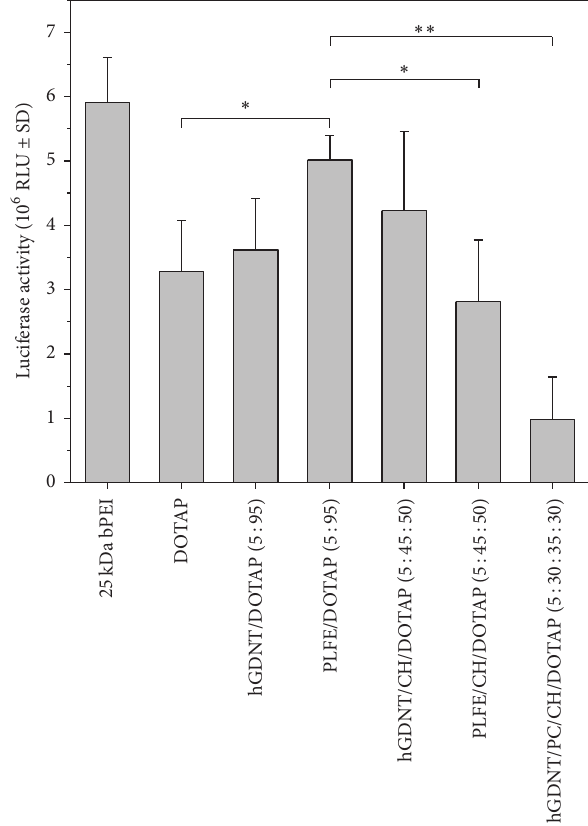
Figure 14: Transfection efficiency of various formulations. ∗ 𝑝 < 0.05 ; ∗∗ 𝑝 < 0.01